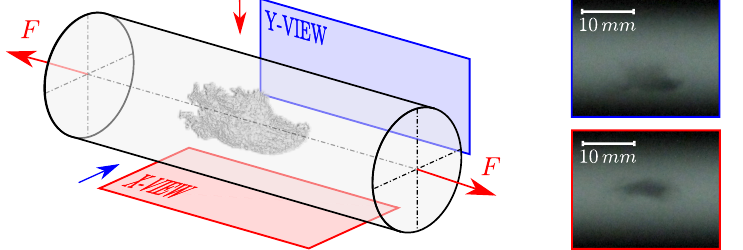
Figure 4. Schematic illustration of the X-ray examination of a representative imperfection.